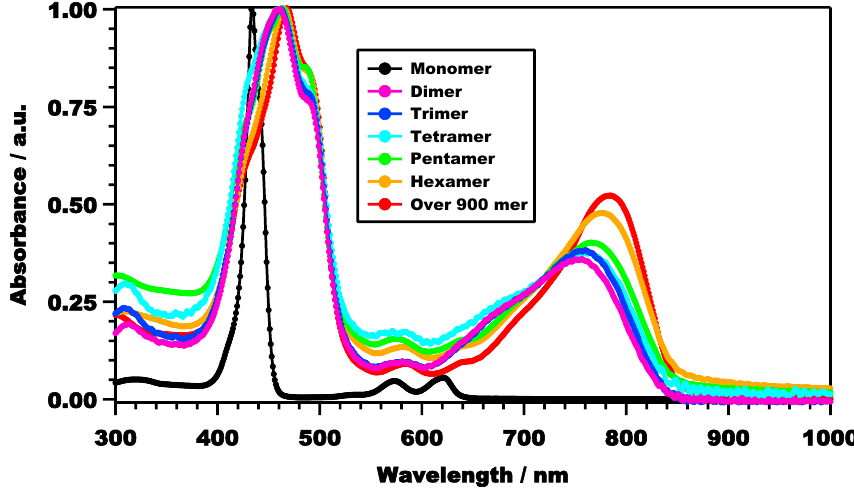
Figure 2. UV-visible spectra of porphyrin monomer ( 1e ), dimer, trimer, tetramer, pentamer, hexamer, and porphyrin polymer ( 1f ), measured in THF. The spectra show an obvious chemical red-shift in both the Soret band and Q-band compared with the monomer ( 1e ) due to the polymerization as well as a high degree of conjugation of the separated products of polymer species.